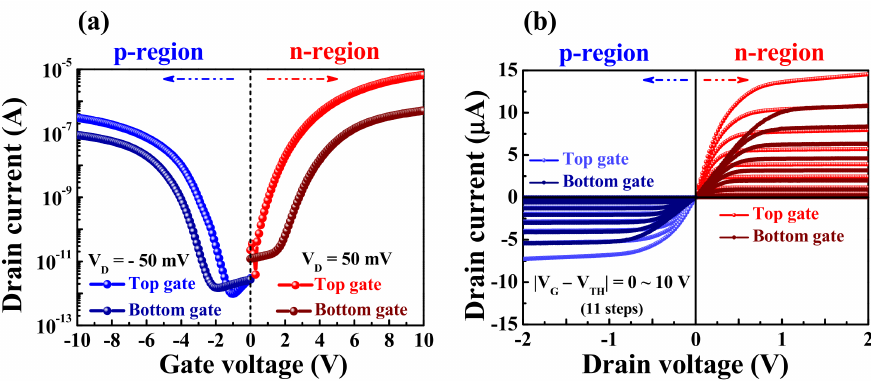
Figure 4. Transfer characteristic (V G –I D ) curves of the bipolar DG ISFETs operated by the top- or bottom-gate voltages in the ( a ) p and n regions. ( b ) Output characteristic (V D –I D ) curves of the bipolar DG ISFETs operated by the top- or bottom-gate voltages in the p and n regions,